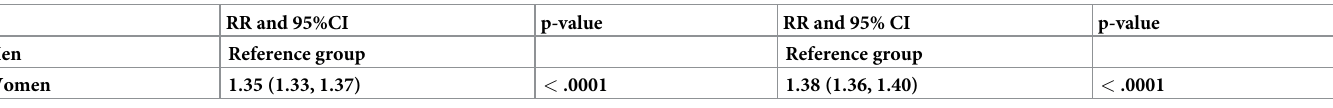
Table 3. Risk ratios for biological sex on BMI � 25 during the COVID-19 pandemic risk ratio before propensity score matching risk ratio after propensity score